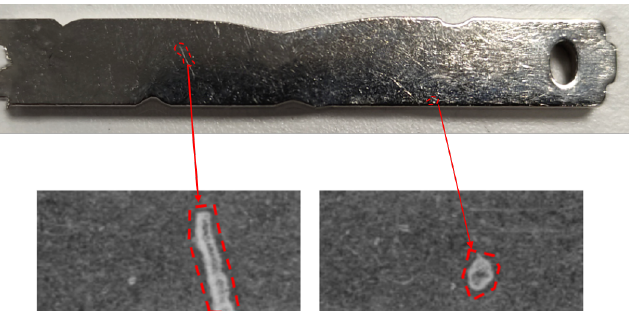
Figure 1. ( Top ) Conventional (non-photometric stereo) image of a manufactured component. ( Bottom ) Samples of component defects acquired with photometric stereo